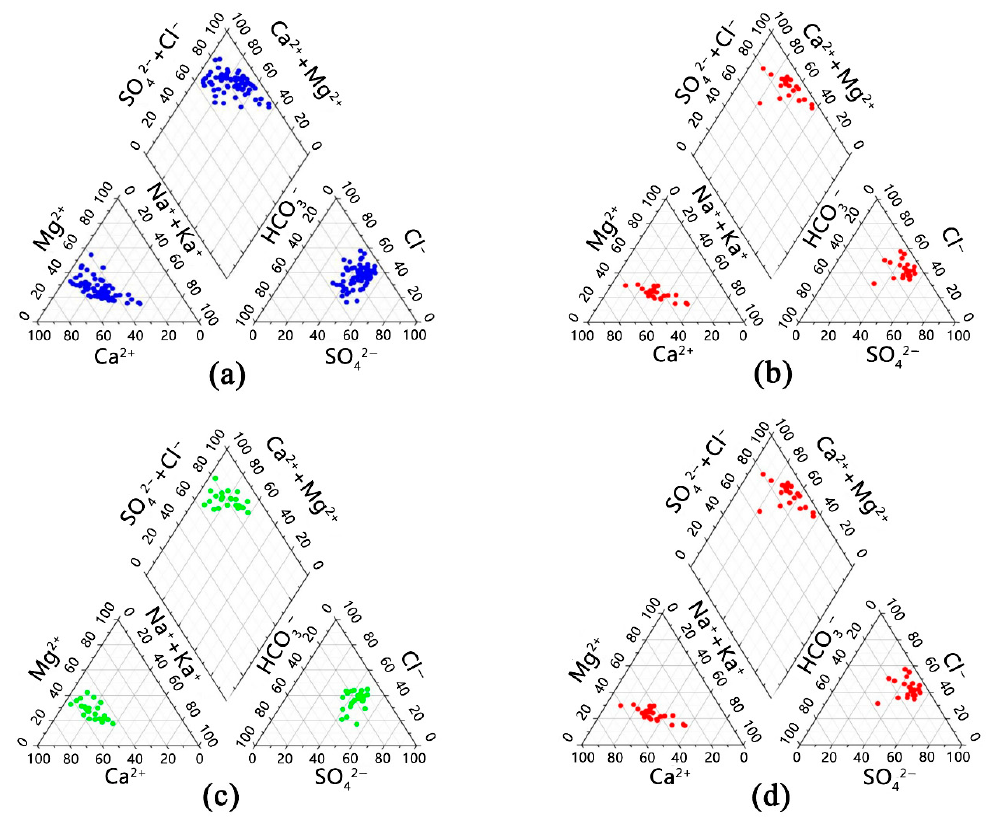
Figure 5. Piper trilinear diagram of water chemical type for the three different areas of the region: ( a ) entire area, ( b ) east area, ( c ) middle area, and ( d ) west area.